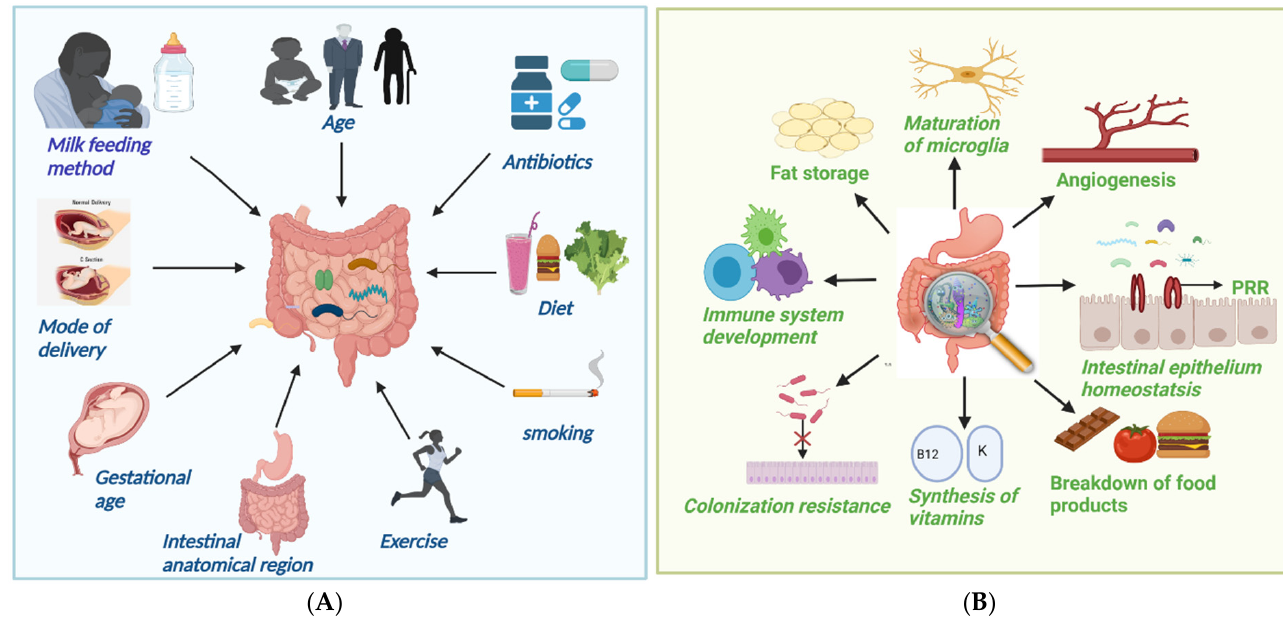
Figure 1. ( A ) Factors causing alteration in gut microbiota; ( B ) Important function of gut microbi-